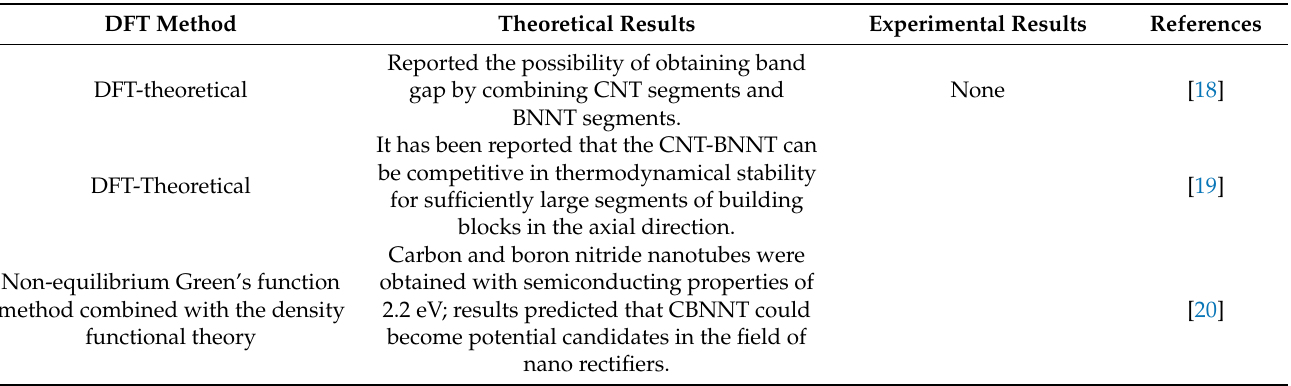
Table 1. Available studies on band gap in hybrid nanostructures by various